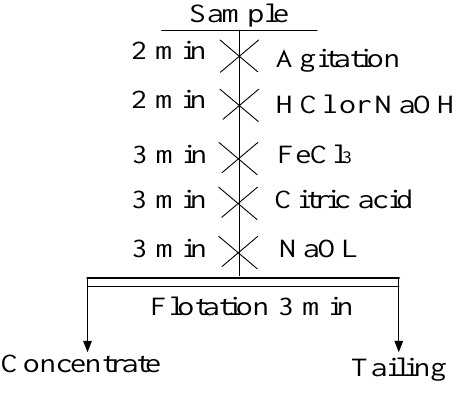
Figure 2. Procedure for flotation tests.